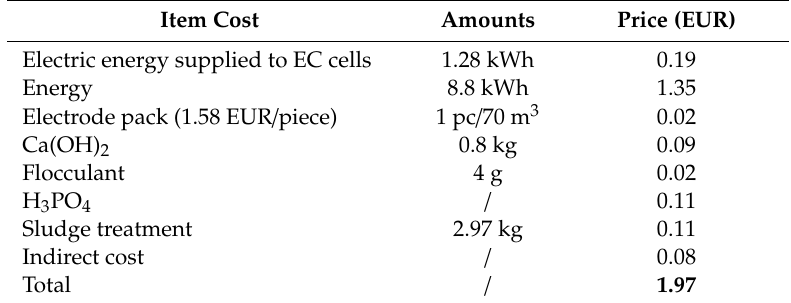
Table 8. Operating cost for treatment of 1 m 3 of contaminated water on industrial